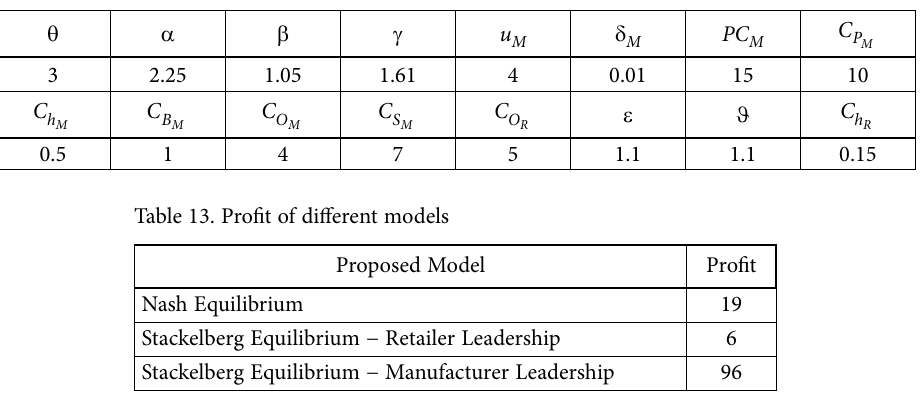
Table 12. Initial information of numerical example